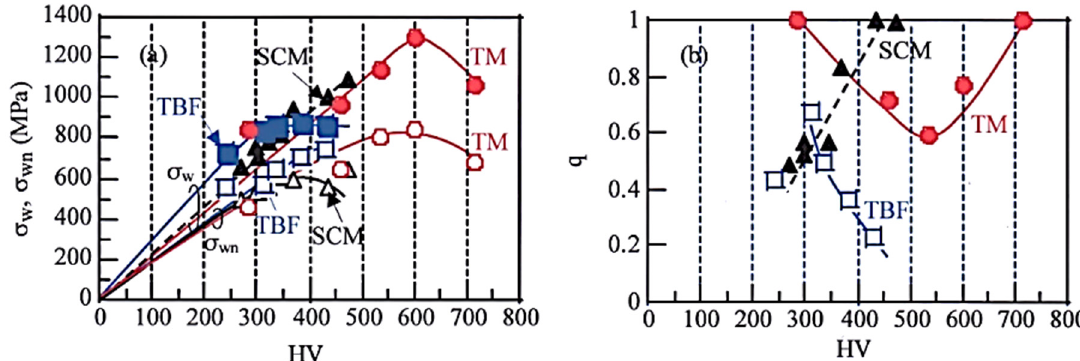
Figure 12. Variations in ( a ) fatigue limits ( σ w , σ wn ) of smooth and notched specimens and ( b ) notch-sensitivity ( q ) as a function of Vickers hardness (HV) in (0.1–0.6)%C–1.5%Si–1.5%Mn TM steels subjected to DQ-P process ( T p = 250 ° C, ● ○